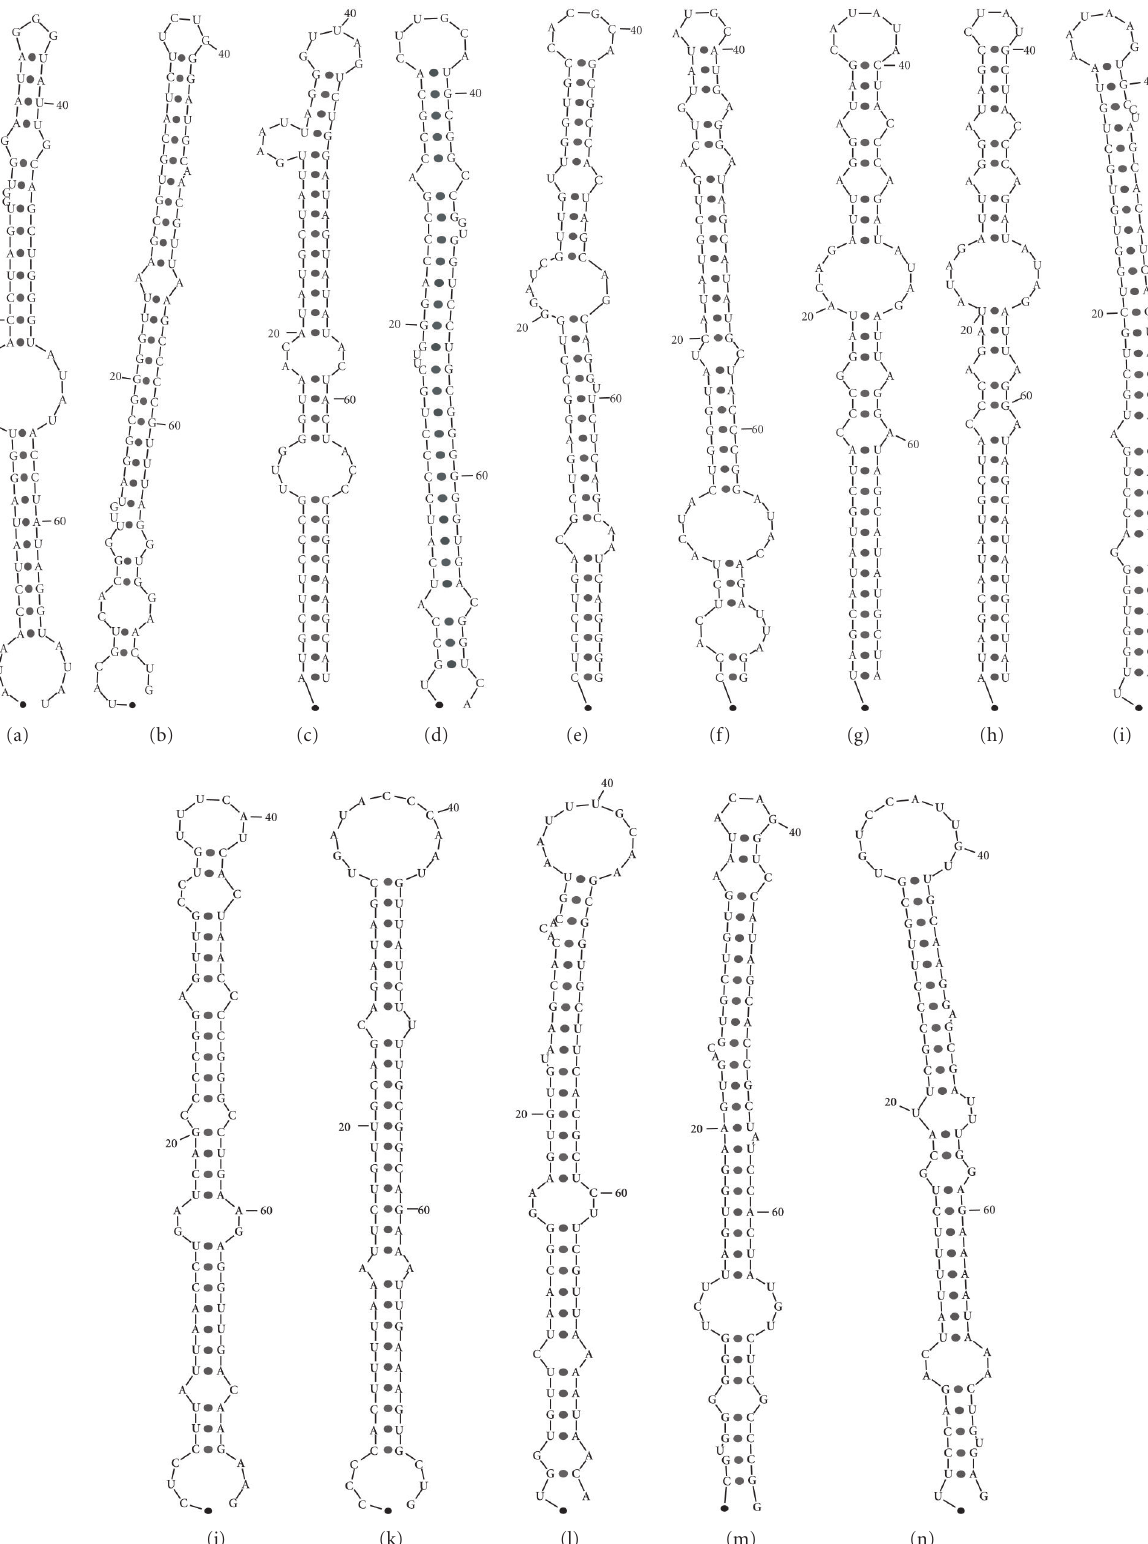
Figure 2: (a)–(i) The predicted structure of the nine top scoring novel miRNA precursor candidates. (j)–(n) The predicted structure of the five known EBV miRNA